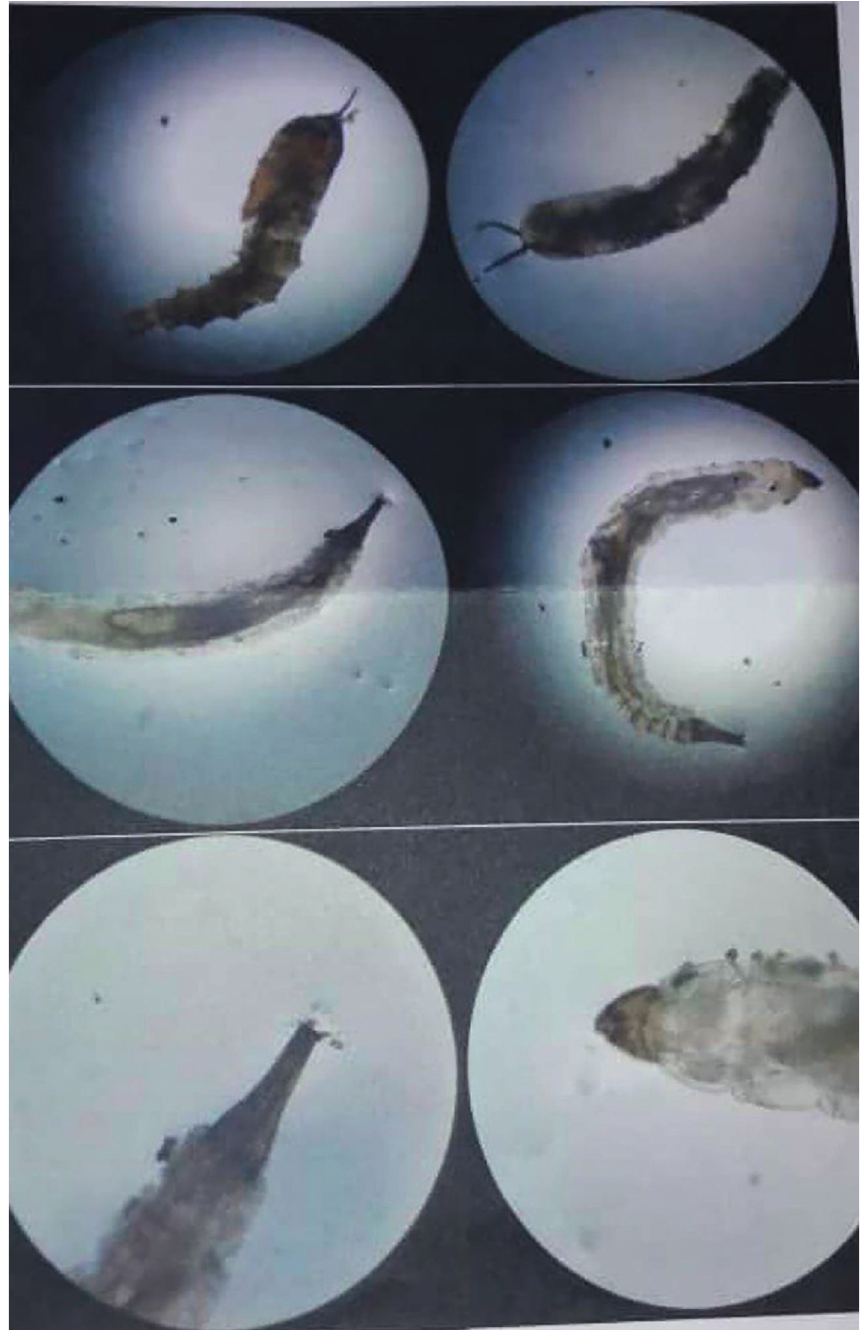
Figure 1: Urine analysis reported a large number of larvae (a maximum size of 4mm) without RBC or WBC. The morphology of the larvae was compatible with